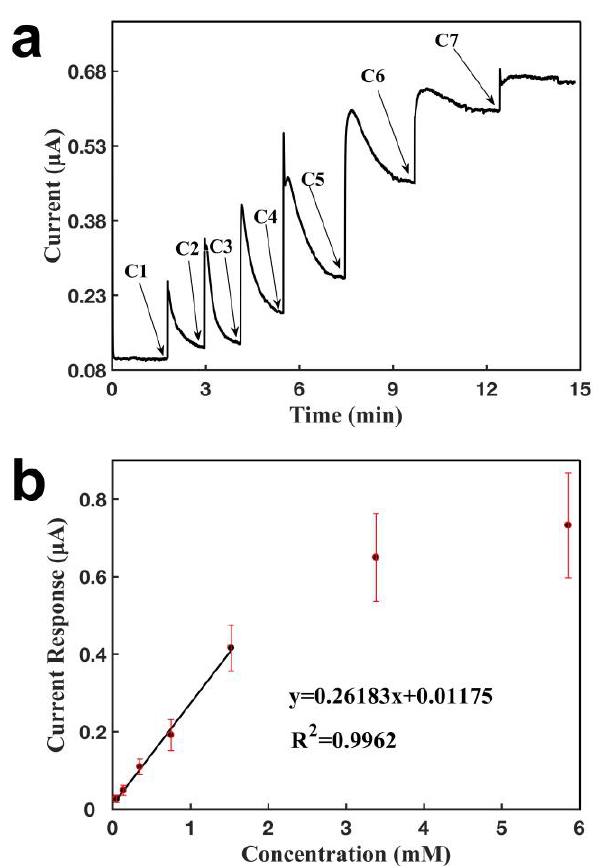
Figure 8. Characterization of a glove sensor based on two CNT electrodes, and an Ag/AgCl electrode for the detection of lactate. Operating potential: 0.6 V of the working electrode vs reference electrode (Ag/AgCl 50:50). ( a ) Current-verses-time response curve upon the additions of lactate. C1: 0.048 mM, C2: 0.089 mM, C3: 0.30 mM, C4: 0.40 mM, C5: 0.77 mM, C6: 1.86 mM, C7: 2.47 mM. ( b ) Calibration curve for the detection of lactate. Each error bar was from three measurements.